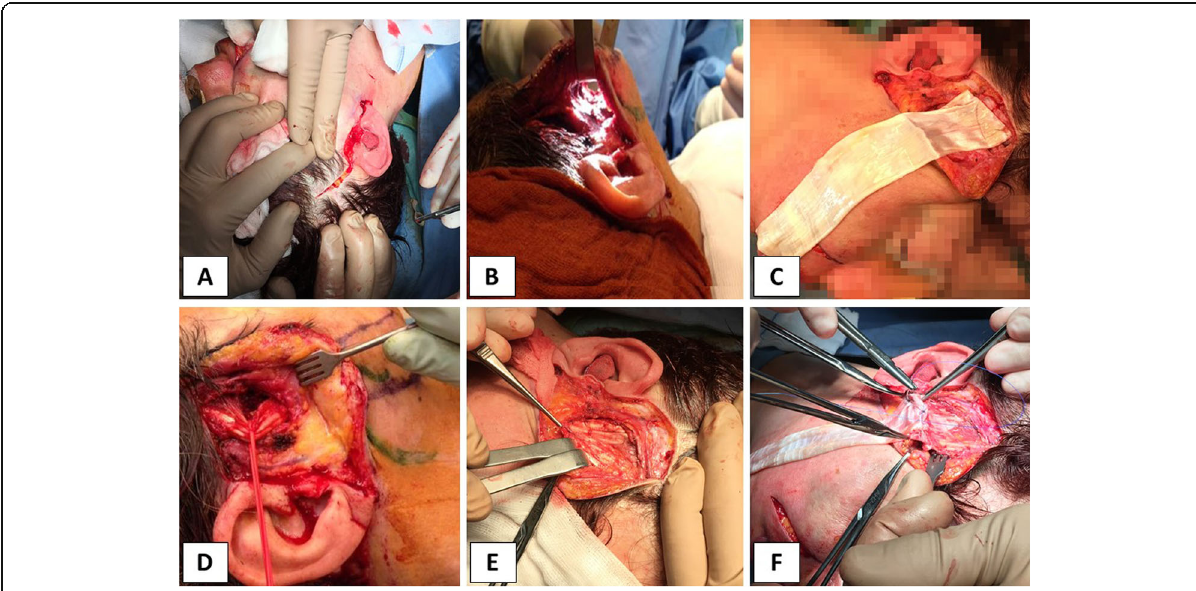
Fig. 1 Intraoperative images. a Preauricular incision extending to postauricular and temporal area. b Subcutaneous tunnel. c Cadaveric fascia lata graft. d Temporalis tendon dissection. e Exposed temporalis tendon. f Cadaveric fascia lata graft sutured to the temporalis tendon